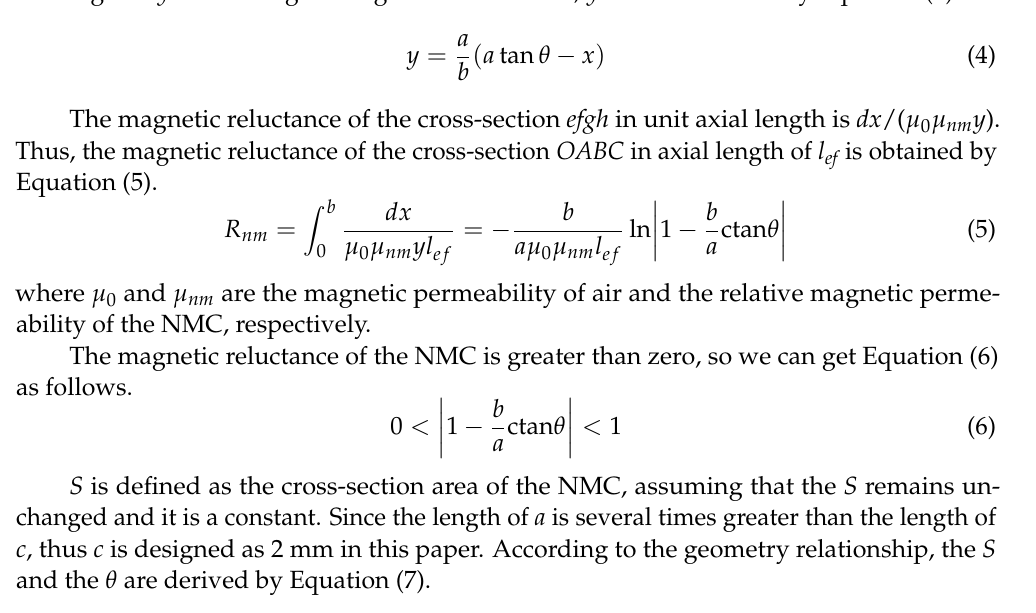
Figure 12. The shape of the non-magnetic conductor. θ is defined as the angle between OA and AB. θ can change from 0 ◦ to 90 ◦ . The hypotenuse of the actual NMC shape is replaced by the line AB . a , b and c are defined as lengths of OA , OC and CB , respectively. Take a small section of dx on the x- axis, and the height is y . According to the geometric relation, y can be obtained by Equation (4).